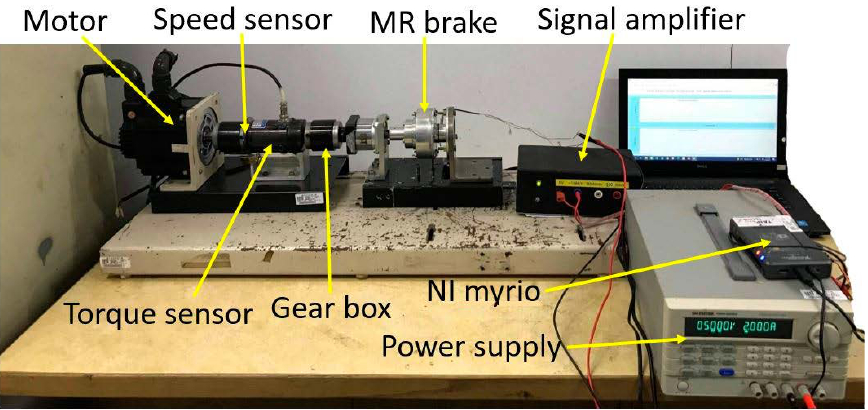
Figure 6. Test bench of MR brake.